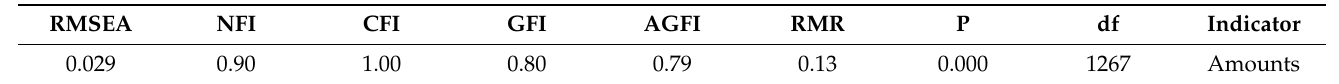
Table 7. Fitness indicators of training needs assessment of female rice farmers. RMSEA NFI CFI GFI AGFI RMR P df Indicator 0.029 0.90 1.00 0.80 0.79 0.13 0.000 1267